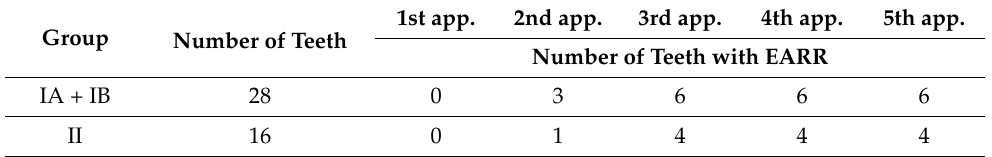
Table 7. Number of teeth with radiologically detected external apical root resorption in studied groups. Group